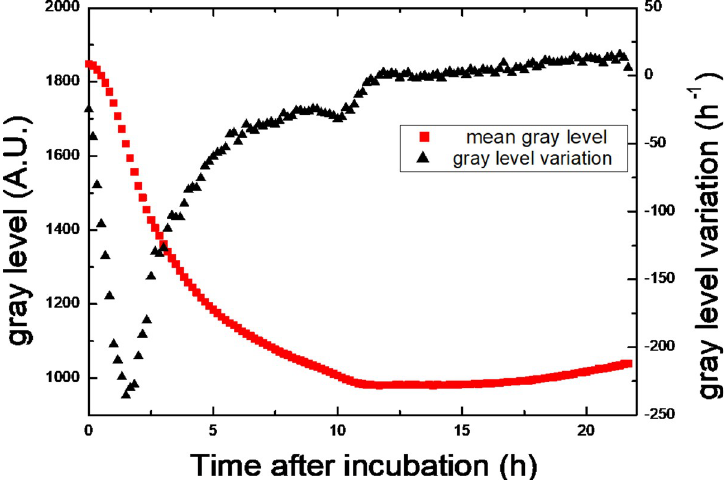
Fig 5. Evolution of the mean gray level (red curve) of bacterial lawn and its variation (black curve). The gray level variation is the derivative of the mean gray level. It highlights the evolution of the growth rate of the bacteria inside the lawn. It is maximal after 2 hr of